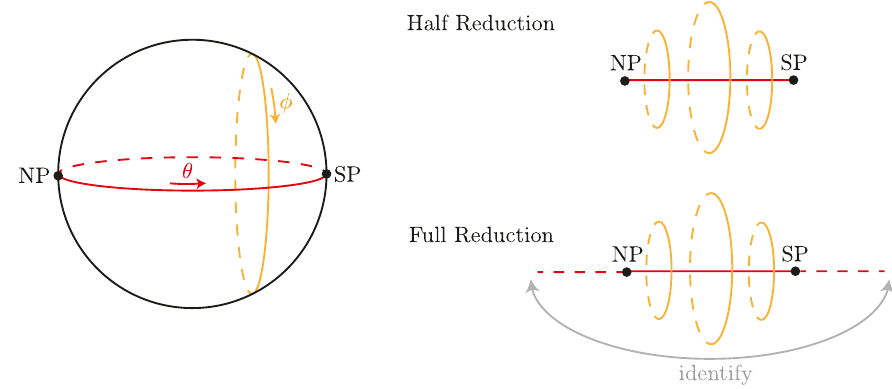
Figure 1 . Left: constant time slice of de Sitter space in static coordinates. The polar angle θ runs from − π/ 2 to + π/ 2 and the azimuthal angle φ = φ + 2 π . Right: to obtain a two-dimensional dilaton gravity model we perform a reduction over the S 1 parametrized by φ . We consider both a “half reduction” where we restrict θ to run from − π/ 2 to + π/ 2 and a “full reduction” where θ = θ + 2 π . The circumference of the orange S 1 indicates the size of the dilaton, which becomes negative in the red dotted region in the full reduction.